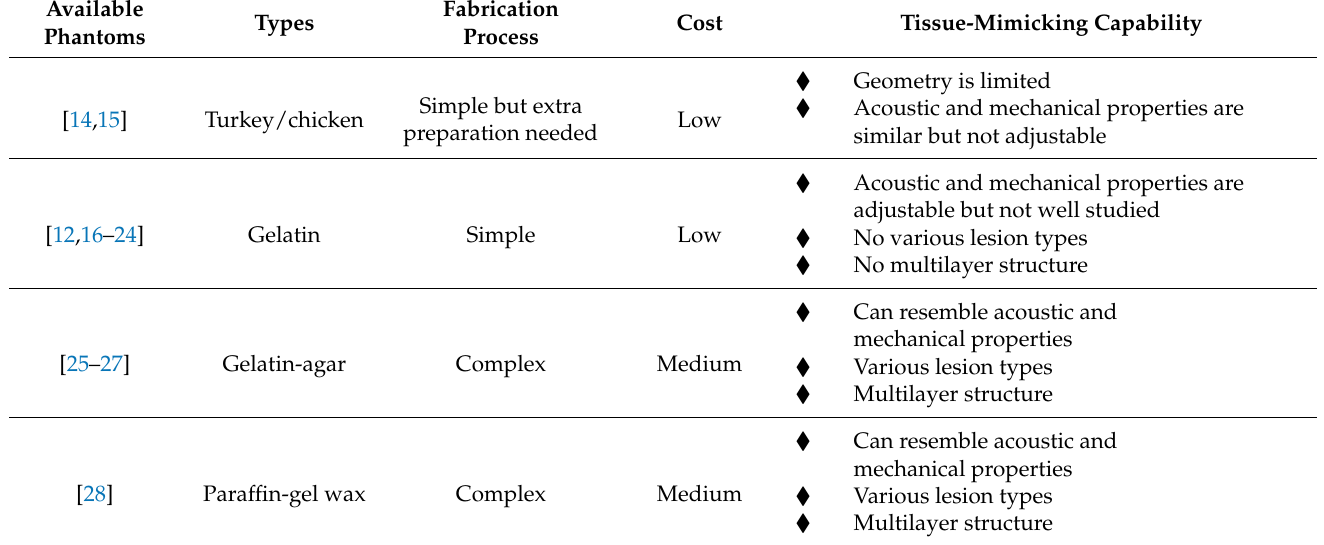
Table 1. A comparison of existing methods and commercial products of tissue mimicking breast phantom.